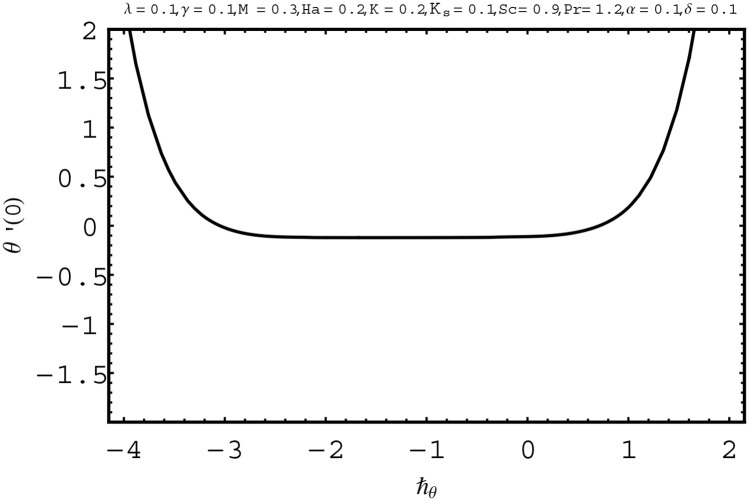
ℏ− curve for θ(η).